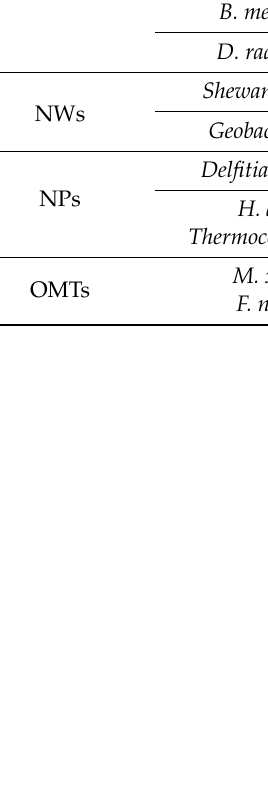
Table 3. Tubular membranous nanostructures found in bacteria of different species.